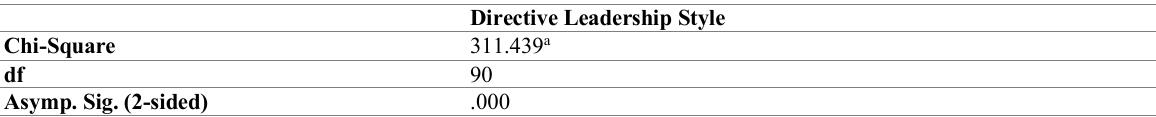
Table 3: Chi-square Test for Directive Leadership Style